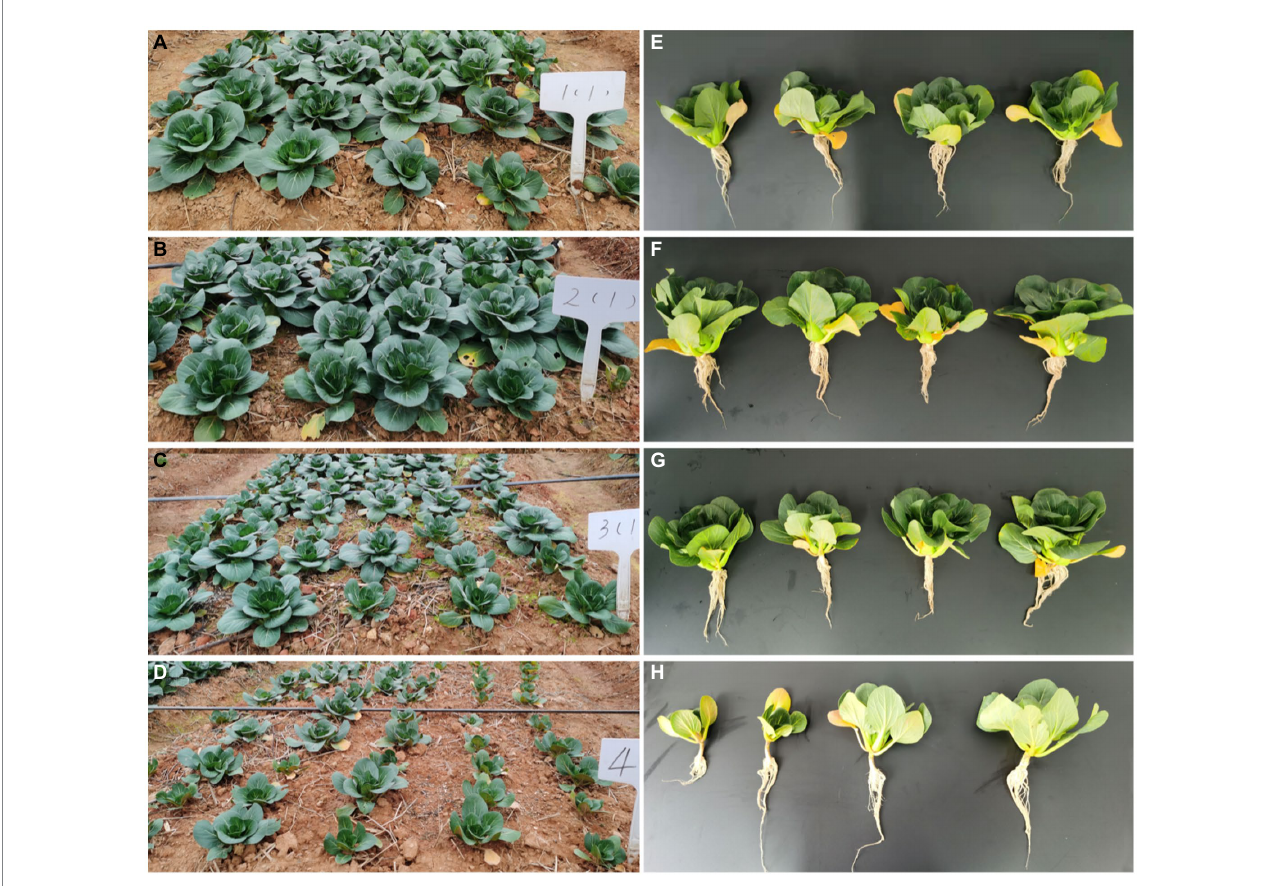
FIGURE 1 Effect of MF-HZ23 on the growth of pakchoi in the newly reclaimed filed. (A,E) MF-HZ23 at 3.00 kg/m 2 (T1); (B,F) MF-HZ23 at 3.00 kg/m 2 plus CCF at 0.02 kg/m 2 (T2); (C,G) CCF at 0.04 kg/m 2 (T3); and (D,H) control.